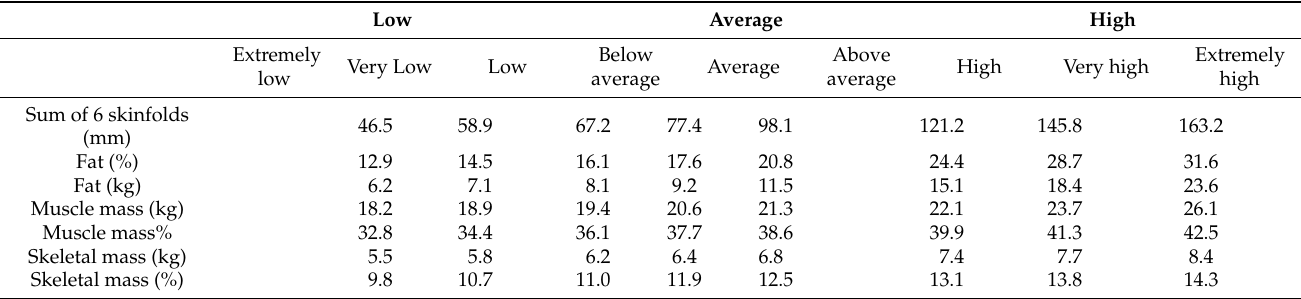
Table 3. Stanines for the body composition of outfield female football